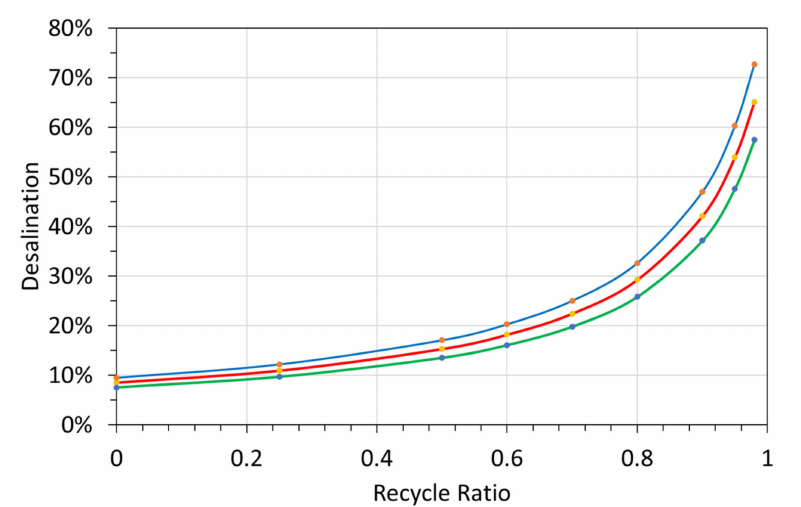
Figure 27. Impact of recycle ratio in the ZVI reactor, on the desalination associated with the ZVI pellets, 50 g L − 1 . The n-C 0 content of the ZVI pellets, may increase with increasing recycle ratio. The graph shows the results for a feed water with a salinity of 5 g L − 1 , and a reaction time of 500 h. Red = median outcome: Blue = upper quartile; green = lower